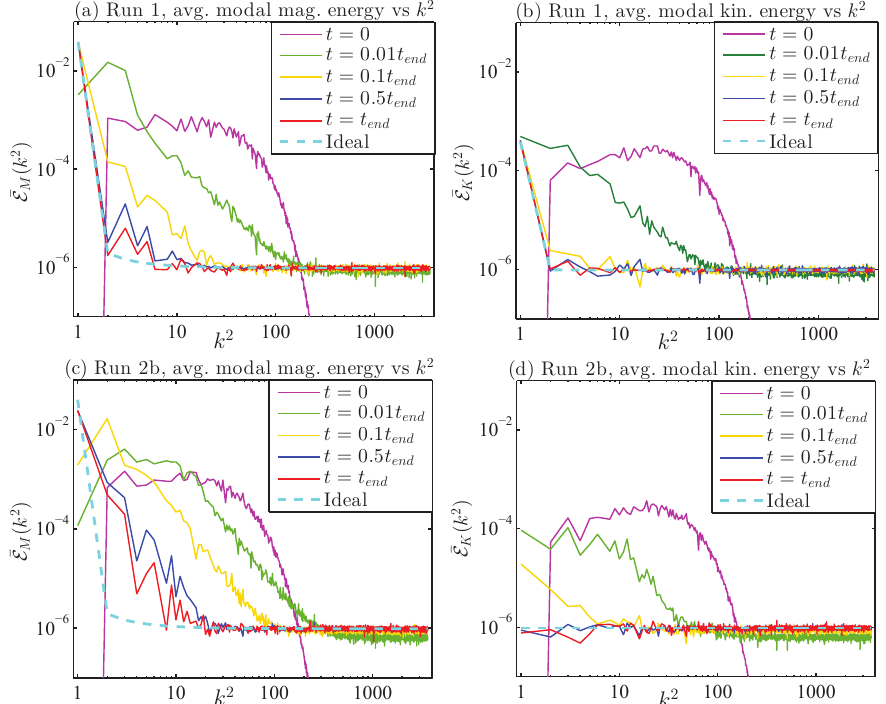
( k 2 ) and ¯ ( k 2 ) , for Runs 1 and 2b. These E M E K 2 ; there are 3036 different values of k | |